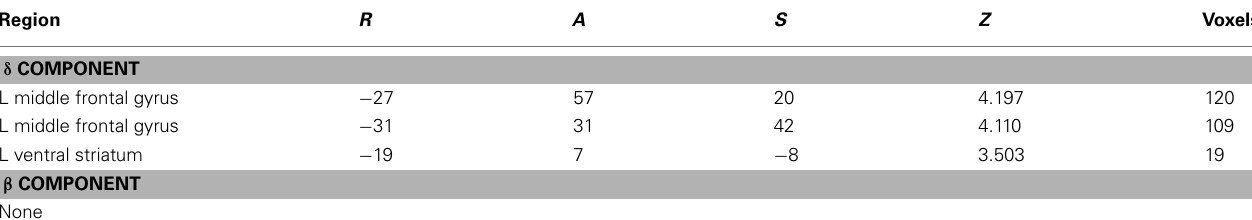
Table 2 |Age differences in regions with low ( δ ) and high ( β ) discount rates (older > younger). Region R